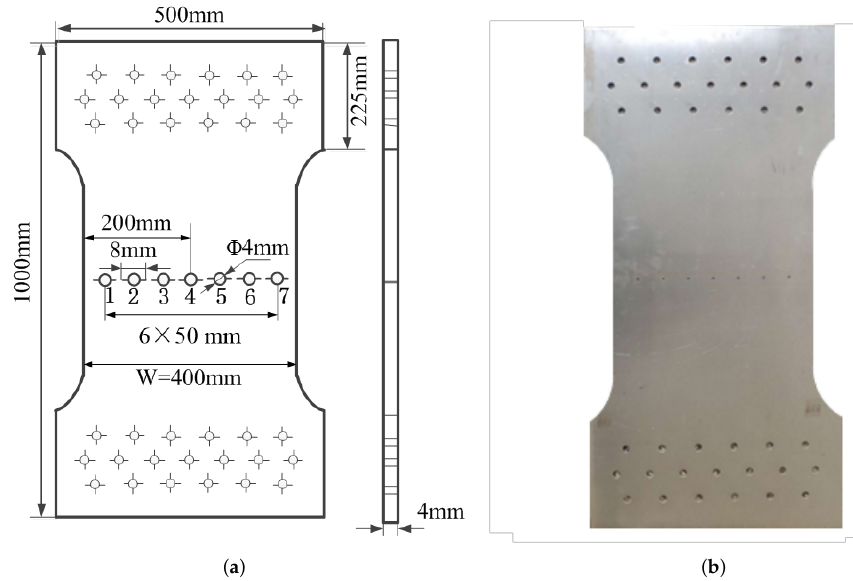
Figure 15. ( a ) Geometric dimensions of 7-hole plate. ( b ) Physical drawing of 7-hole plate.